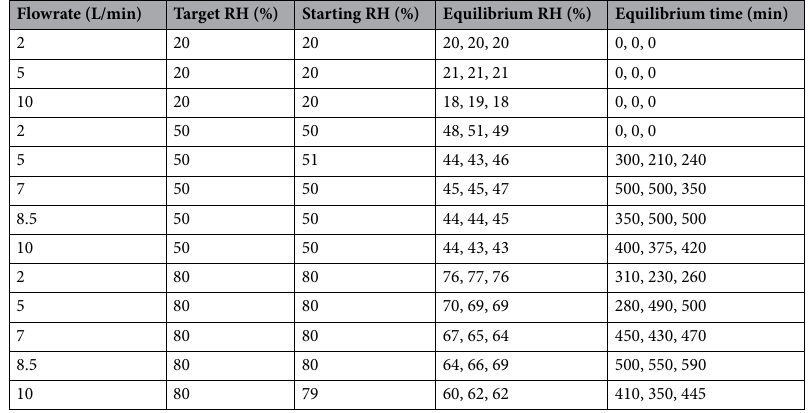
Table 2. RH vs. flowrate results.